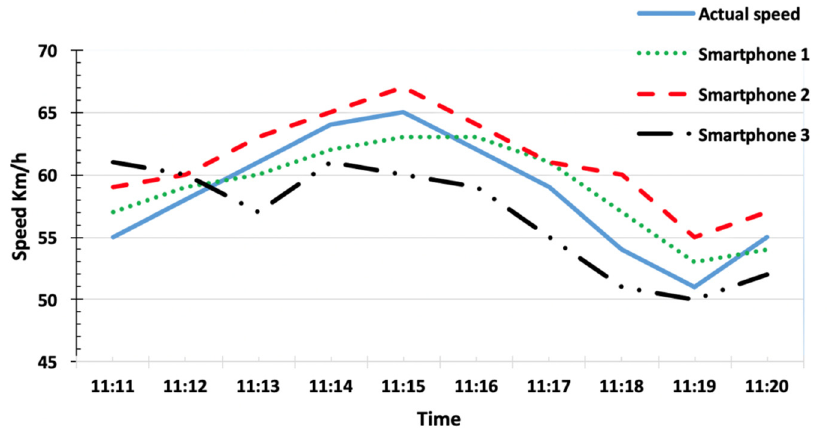
Figure 6. Speed estimation using three smartphones. The speed estimated by smartphone 1 is higher than that of smartphones 2 and 3. This accuracy is due to the high performance of smartphone 1, since it can compute the estimation algorithm and fetch data from memory more quickly than smartphones 2 and 3.